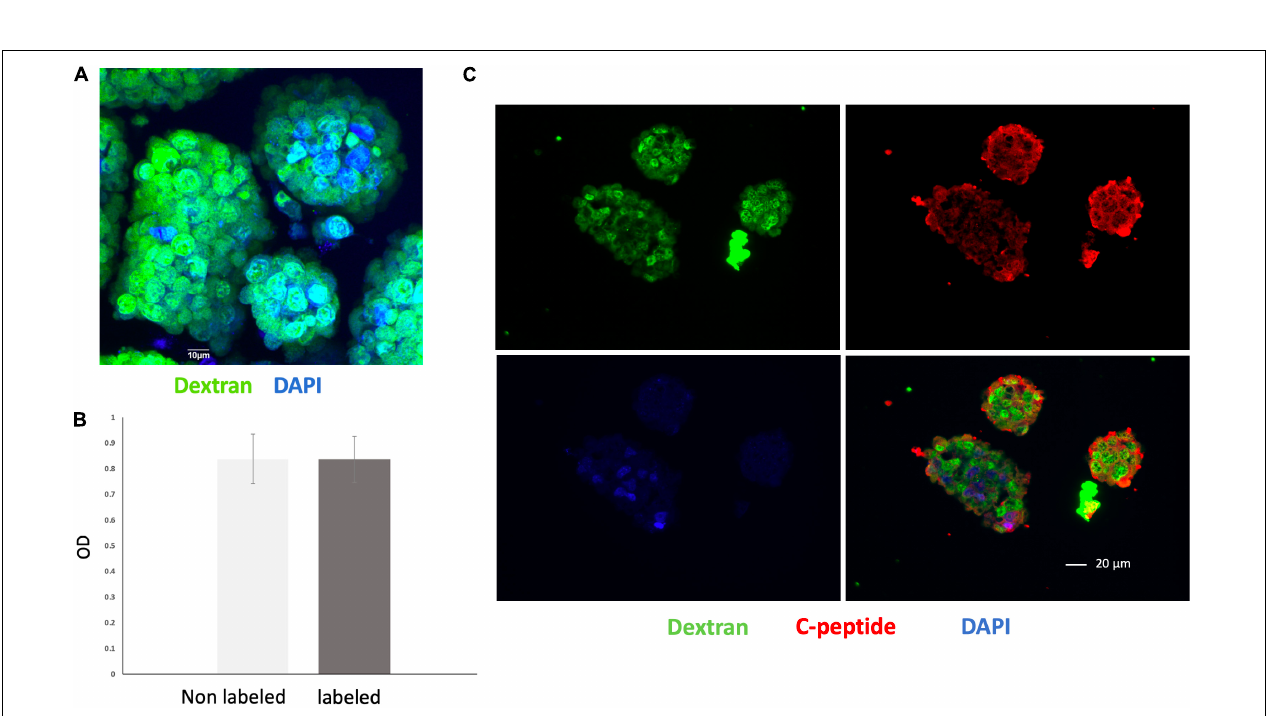
FIGURE 3 | Cell labeling efficiency and viability assay. (A) Anti-dextran fluorescence immunostaining of islet organoids confirming successful VivoTrax labeling dextran coating (green), and cell nuclei (DAPI, blue), magnification bar = 10 µ m. (B) MTT assay showed that VivoTrax labeling did not affect islet organoids viability compared with non-labeled control ( p > 0.05). Data are represented as mean ± SD. (C) Double fluorescence immunostaining for dextran and C-peptide of VivoTrax labeled islet organoids dextran coating (green), C-peptide (red), and cell nuclei (DAPI, blue), magnification bar = 20 µ m.